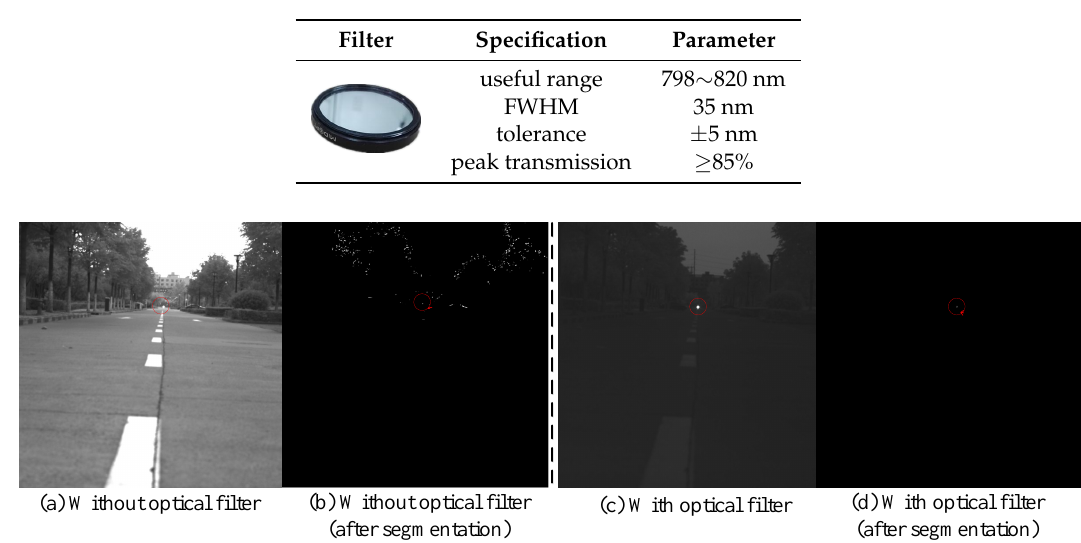
Table 4. The Near-IR interference bandpass filter parameters.